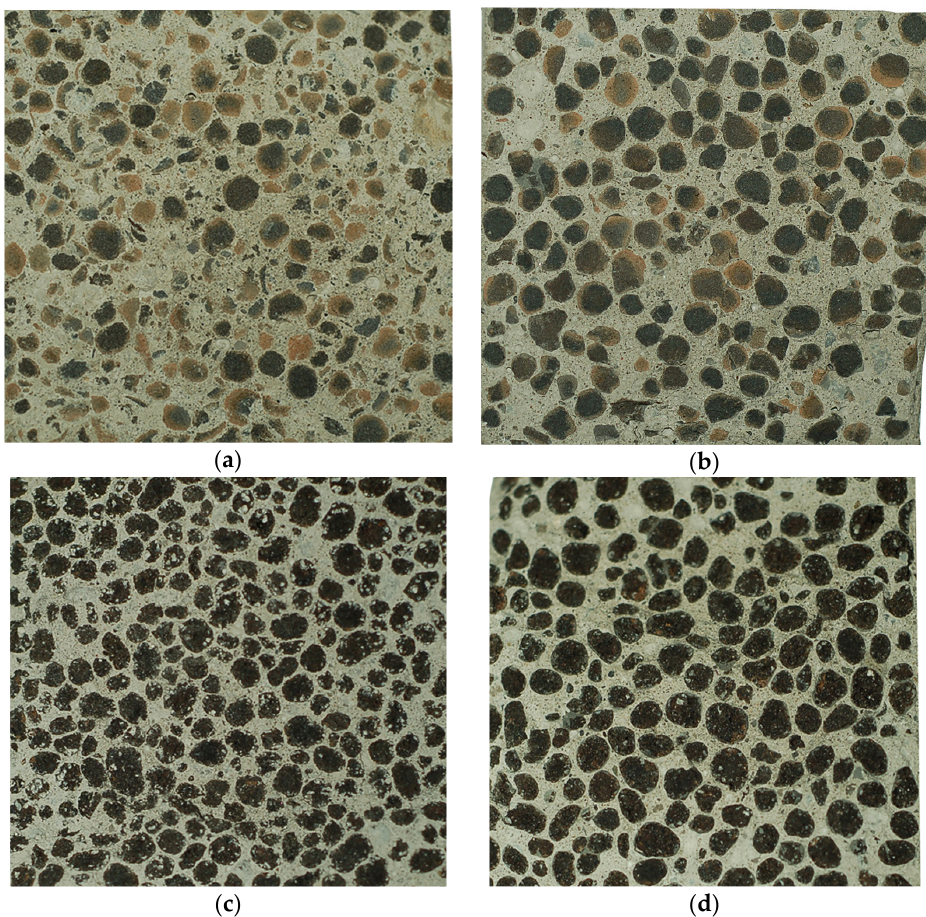
Figure 13. Examples of fracture in composite cube specimens with sides of 100 mm subject to splitting, ( a ) non-impregnated sintered fly ash (FA1), ( b ) impregnated sintered fly ash (FA1d-b), ( c ) non-impregnated expanded clay (EC1), ( d ) impregnated expanded clay (EC1d-a). Meanwhile, in the case of reference concretes made of pre-moistened non-impreg- nated Lytag it happened that individual LWA particles detached from the cement matrix.